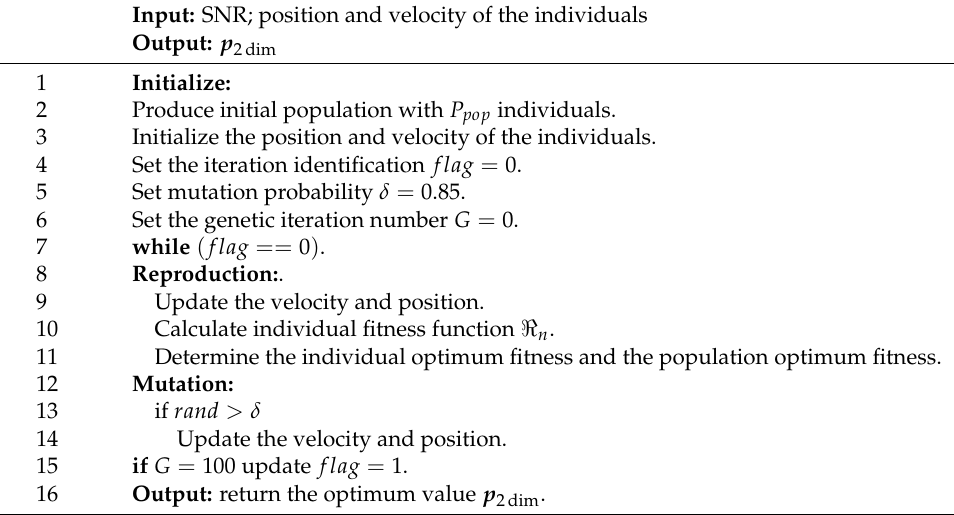
Table 1. Pseudo-code of heuristic